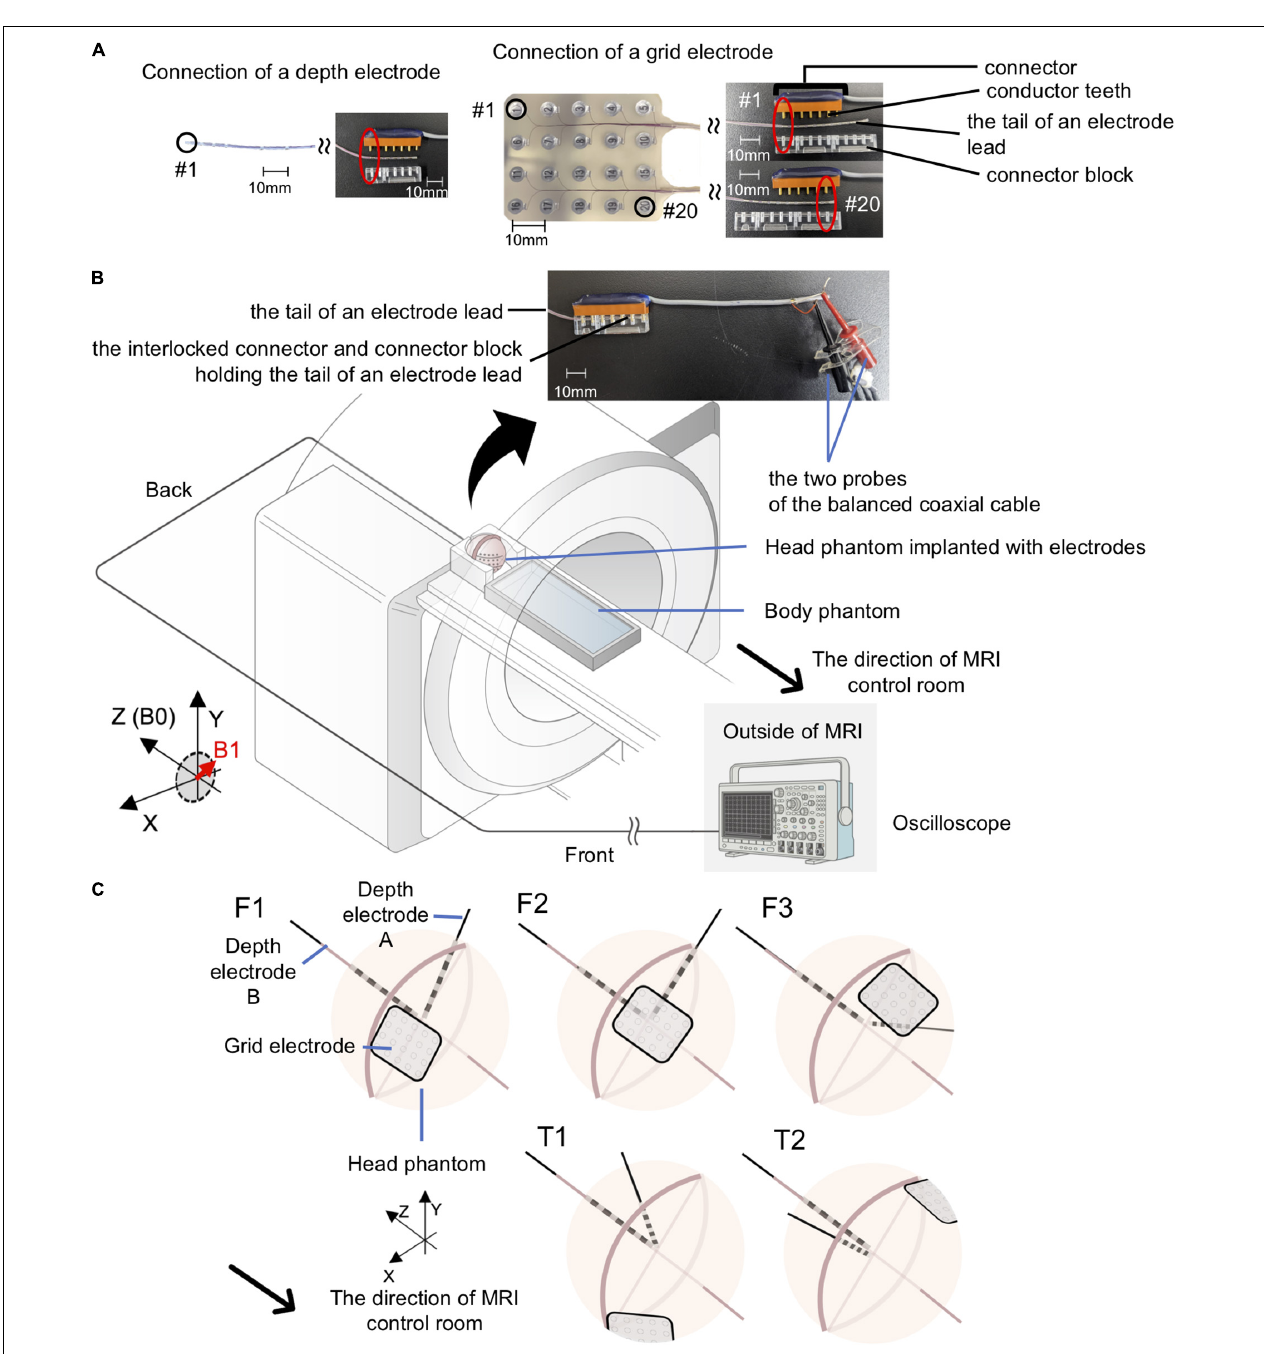
FIGURE 3 | Experimental setup for gradient switching-induced voltage measurement. (A) Modified Ad-Tech connector cables and the electrodes. An Ad-Tech connector cable was cut at 10 cm away from the connector and 2 cm of the cable outer sheath was removed to expose the wires embedded within the cable. Each wire corresponds to one pair of conductor tooth on the connector; connection to an electrode contact can be established by connecting the probe of the balanced coaxial cable to one of these wires. The electrode was connected to the connector via a connector block; connection to any of the contacts on a grid electrode can be achieved by adjusting the relative position of the conductor tooth (on the connector) and the connector block. (B) Layout of the phantoms and all of the equipment during experiments for voltage measurement. Each electrode was connected via a modified Ad-Tech connecter cable (as in A) and a custom-made balanced coaxial cable to the oscilloscope placed outside the magnetic resonance imaging (MRI) in the control room. The electrodes were secured using memory foam cushions (not shown) in the head coil. The portion of electrode leads outside the head coil and the connector were placed at the center of the MRI bore as far away from the head coil as possible and firmly secured using sandbags (not shown). (C) Electrode configurations for voltage measurements. Upper panel – electrode configuration emulating frontal lobe implantation on the right (F1), center (F2), and left (F3). Lower panel – electrode configuration emulating temporal lobe implantation on the right (T1) and left (T2). See Table 2 for electrode contact pairs used for the measurement. Only the Unique medical electrodes are shown for illustrative purpose.